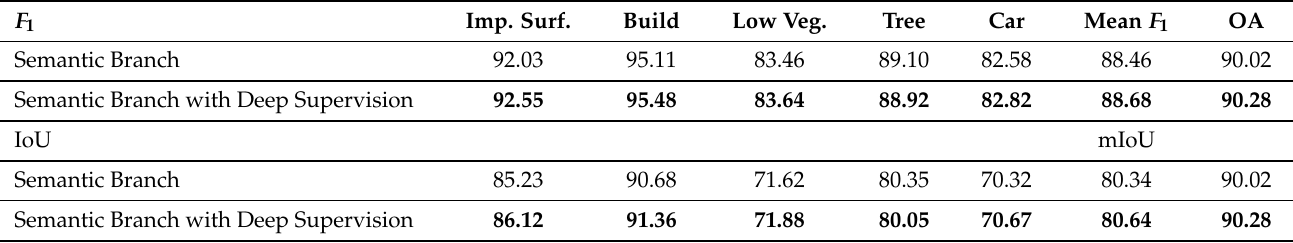
Table 4. The impact of deep supervision on semantic branch.